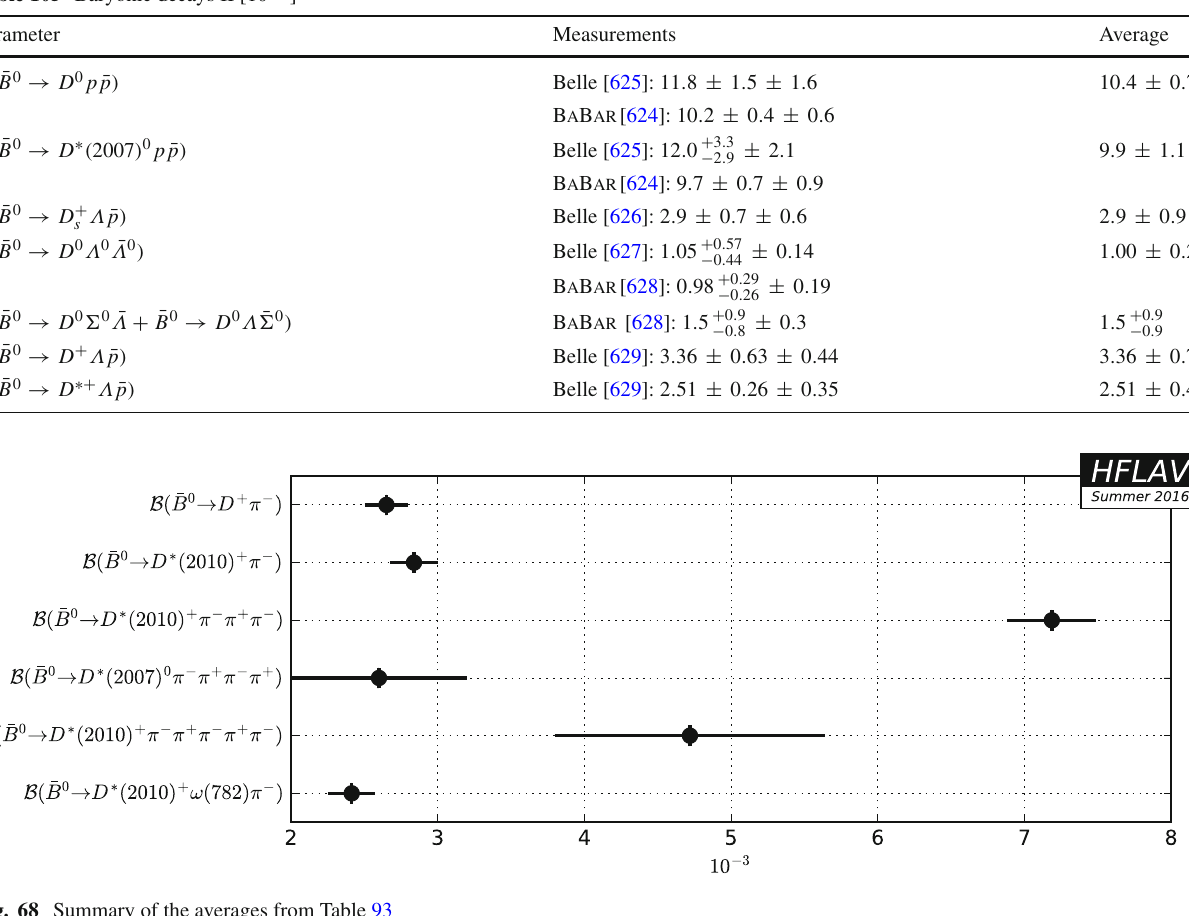
Table 105 Baryonic decays II [ 10 − 5 ]